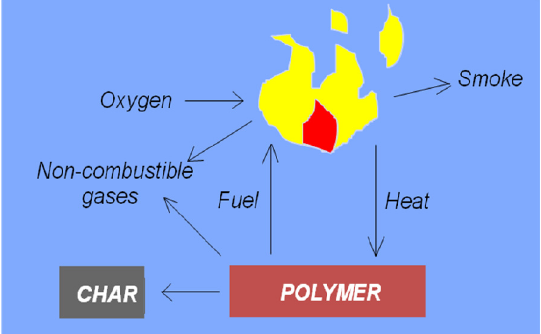
Figure 2. Combustion cycle of a polymeric